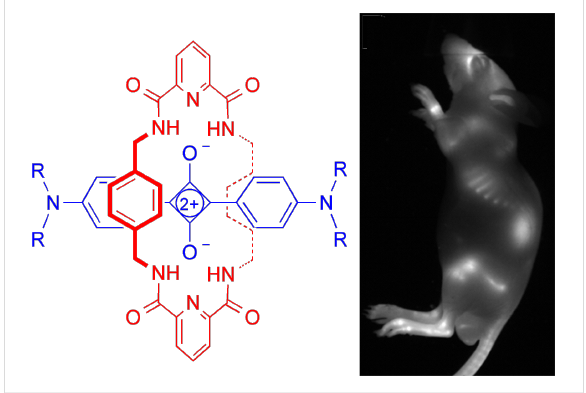
Figure 3: (left) General structure of a squaraine rotaxane dye. (right) Fluorescence image of a living mouse dosed with a squaraine rotaxane probe that selectively targets bone. Reprinted with permis- sion from [37]. Copyright (2013) American Chemical